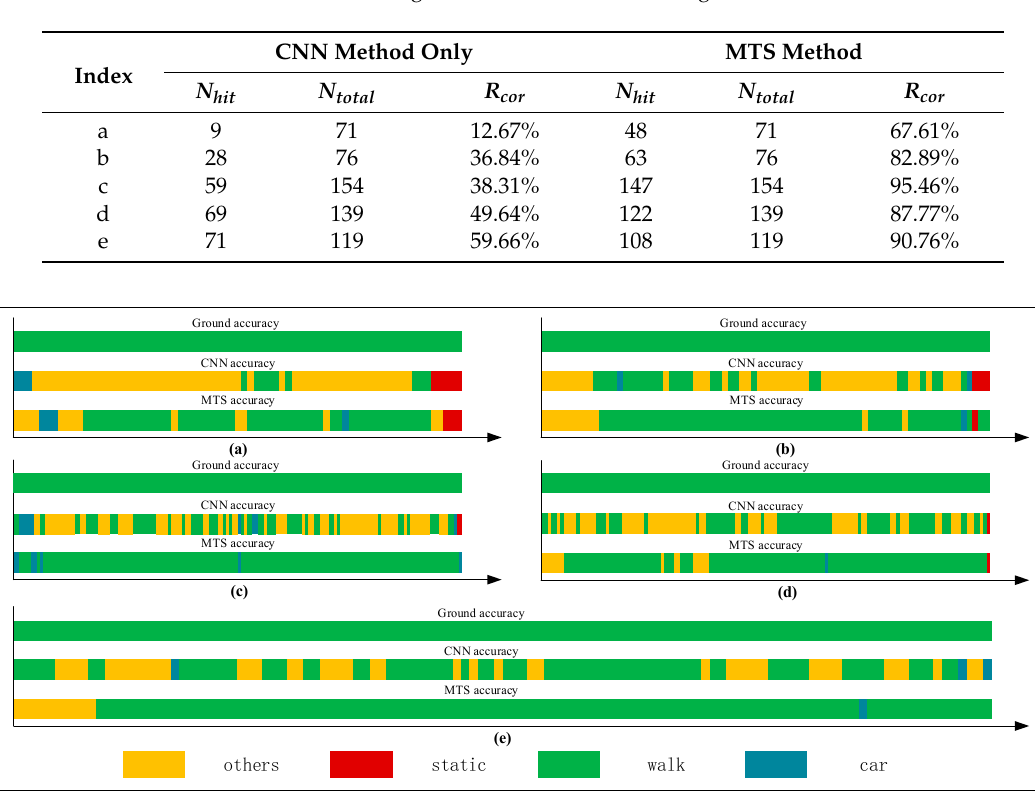
Figure 13. Graphs showing recognition of the stationary state. Table 5. Recognition results for the walking state.